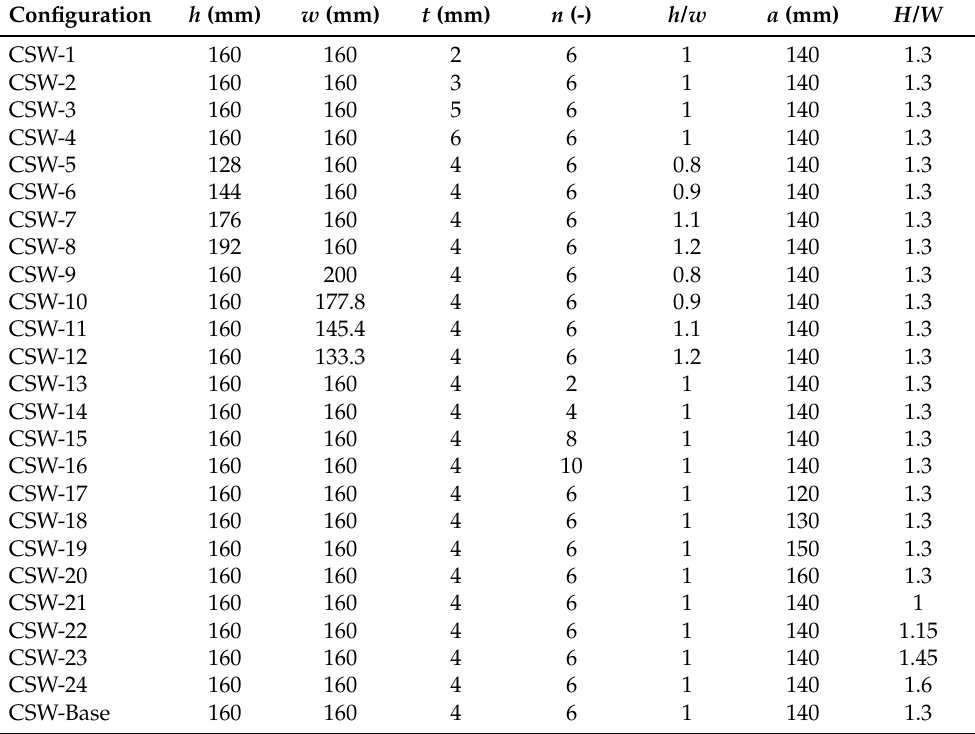
Table 2. Design parameters of individual